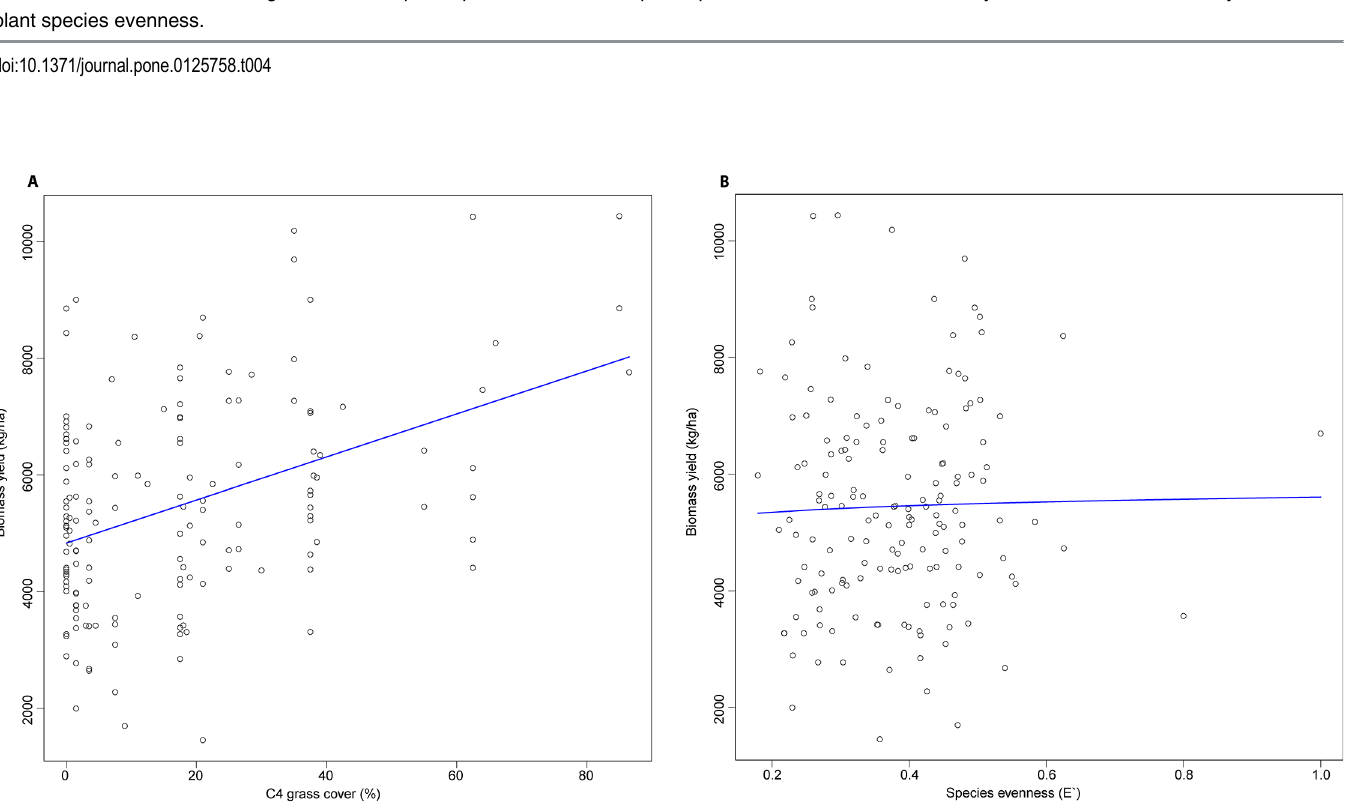
Two models were used in determining parameter values for 2008 and 2009 (Table 1), while three models were used in determining parameter values for 2008 + 2009 (Table 1). †